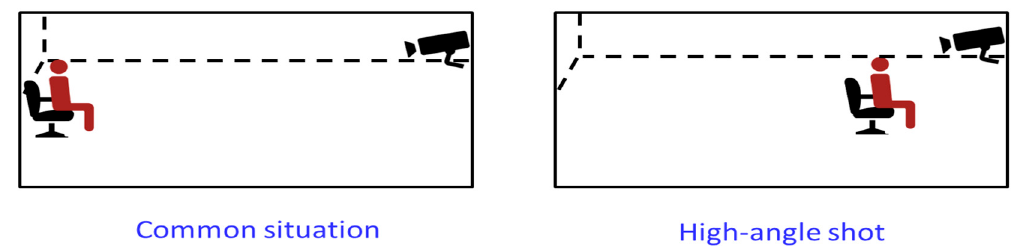
Figure 16. An illustration of a common situation and a high-angle shot.